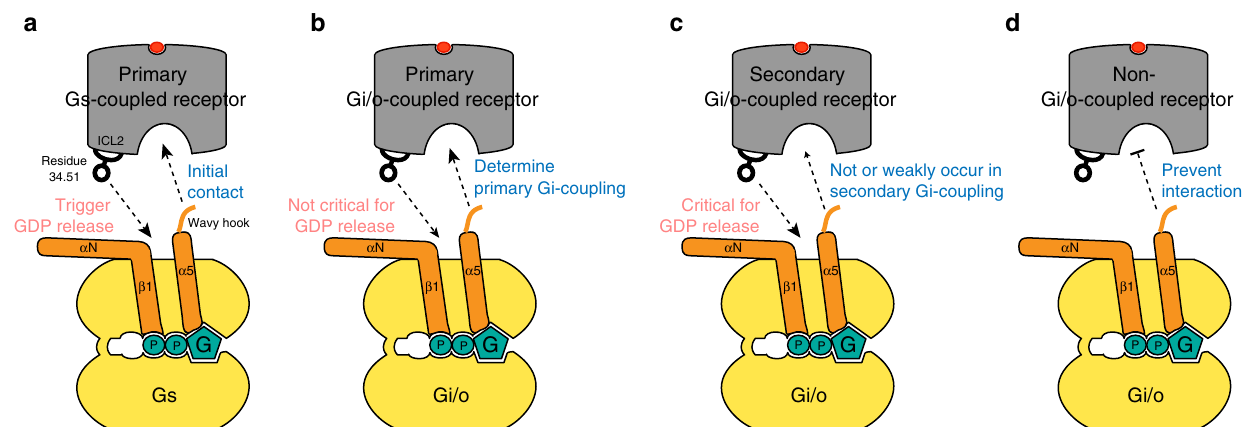
Fig. 6 Summary of Gs and Gi/o coupling mechanisms. a The structural mechanism of primary Gs-coupling based on the study by Du et al. 19 is illustrated. Wavy hook is the initial contact site with a receptor followed by interaction of residue 34.51 at ICL2 with G α s, which triggers GDP release. b , c The structural mechanism of primary and secondary Gi/o-coupling is illustrated. Interaction of the wavy hook with the receptor determines primary and secondary Gi/o coupling. Interaction of residue 34.51 at ICL2 with G α i/o is critical for secondary Gi/o-coupling but not for primary Gi/o-coupling. d The wavy hook of G α i/o prevents coupling with